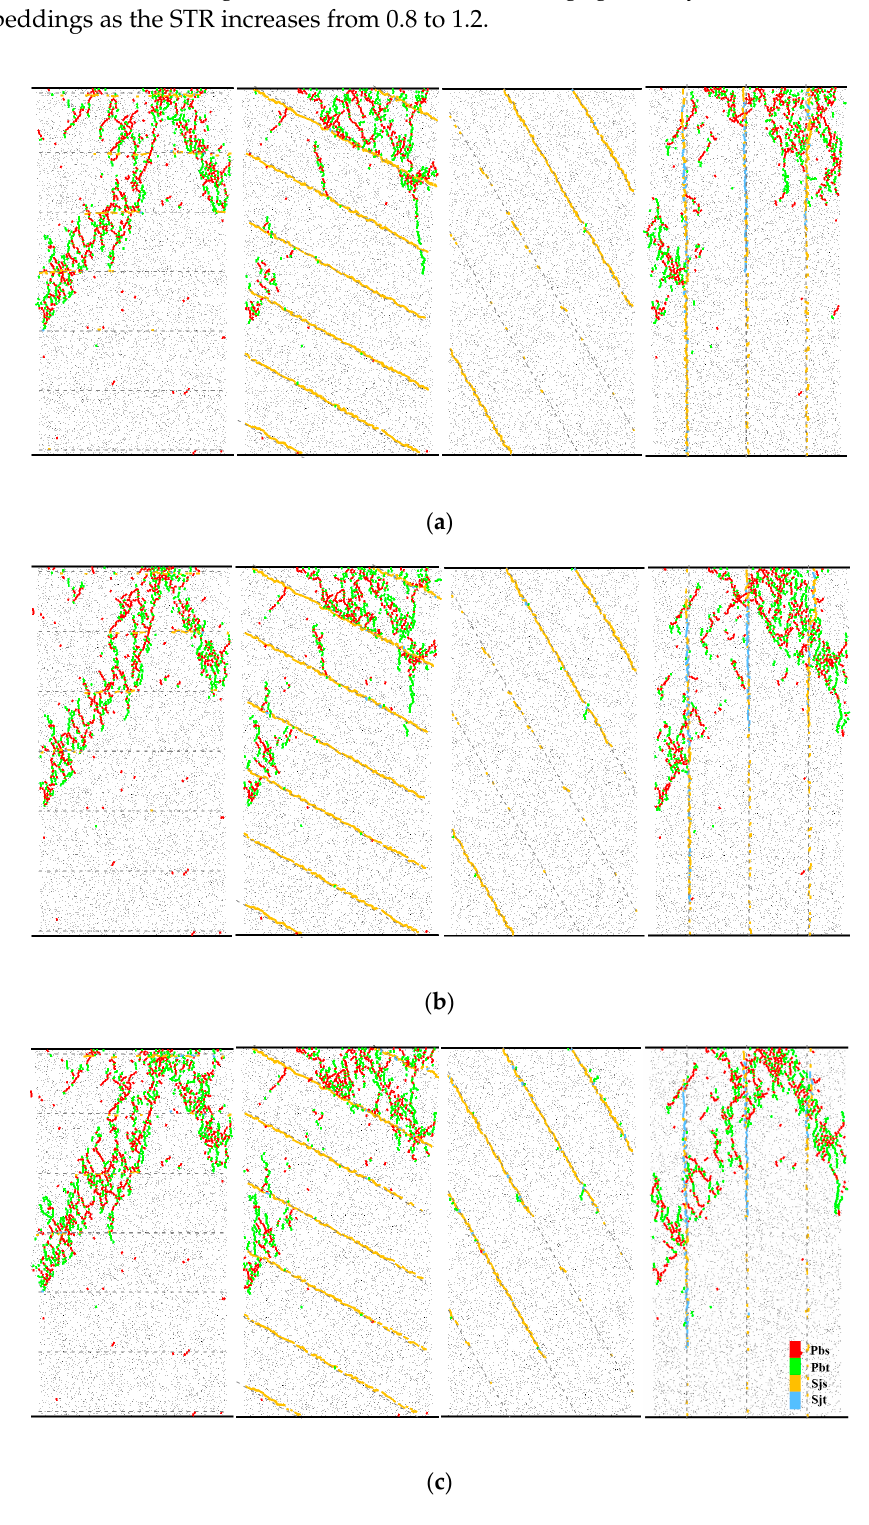
Figure 14. Distributions of crack types at different STRs: ( a ) STR = 0.8; ( b ) STR = 1.0; ( c ) STR = 1.2.